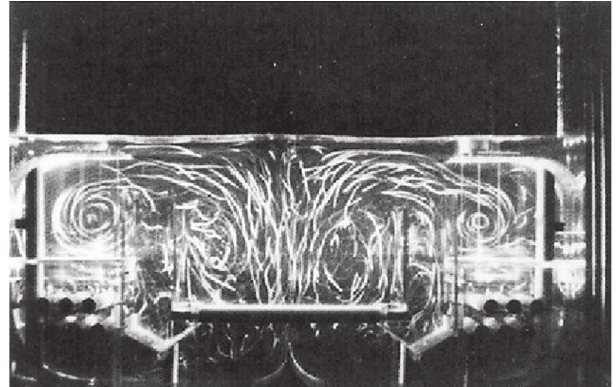
Figure 1. Streak photography of an unloaded quench tank for a SQF.